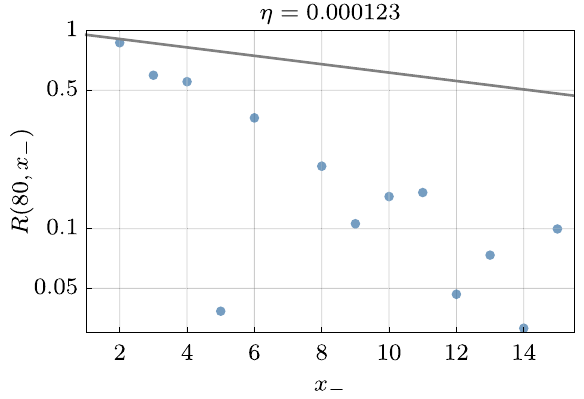
FIG. 9. Correlation functions of operators a ¼ b ¼ σ x at integer sites versus x for a kicked Ising spin chain. Solid lines þ are numerical results, and dashed lines are the predictions of Eq. (43). The results are for a kicked Ising spin chain at J ¼ B ¼ ð π = 4 Þ þ 0 . 01 , h ¼ 1 . 2 , as defined in Eq. (95) with density of defects δ ¼ 1 .